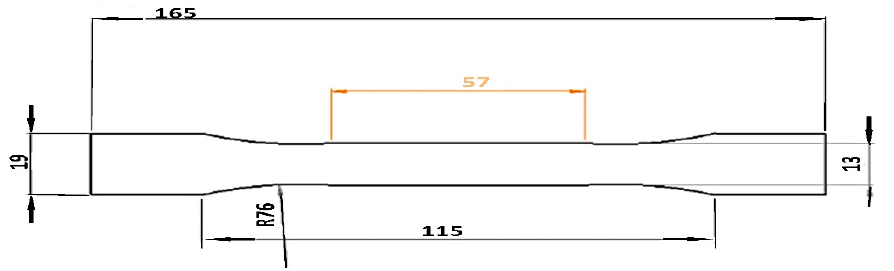
Figure 1. Dimension details of the tensile test sample according to ASTM